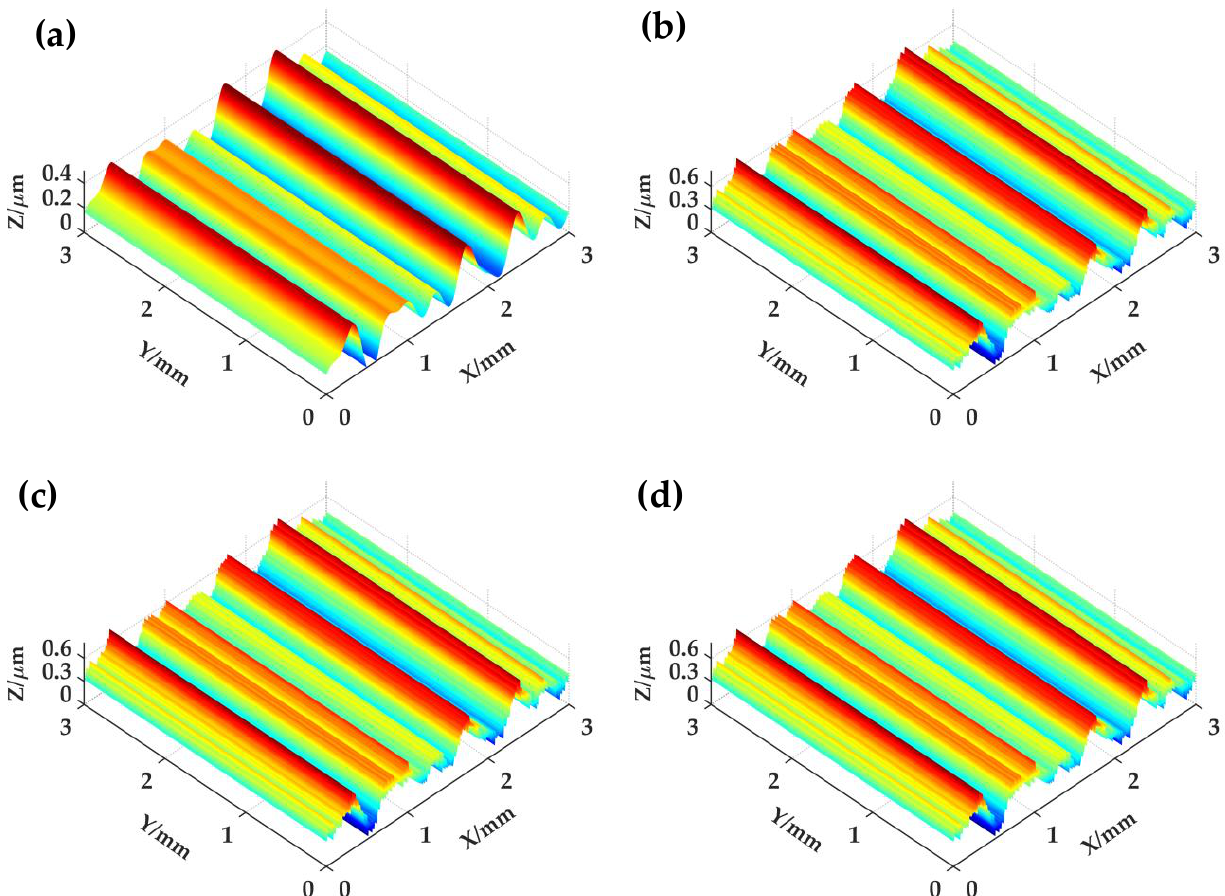
Figure 4. The ubiquitiformal surfaces under different δ min : ( a ) δ min = 10 − 3 m; ( b ) δ min = 10 − 5 m; ( c ) δ min = 10 − 7 m; ( d ) δ min = 10 − 9 m.